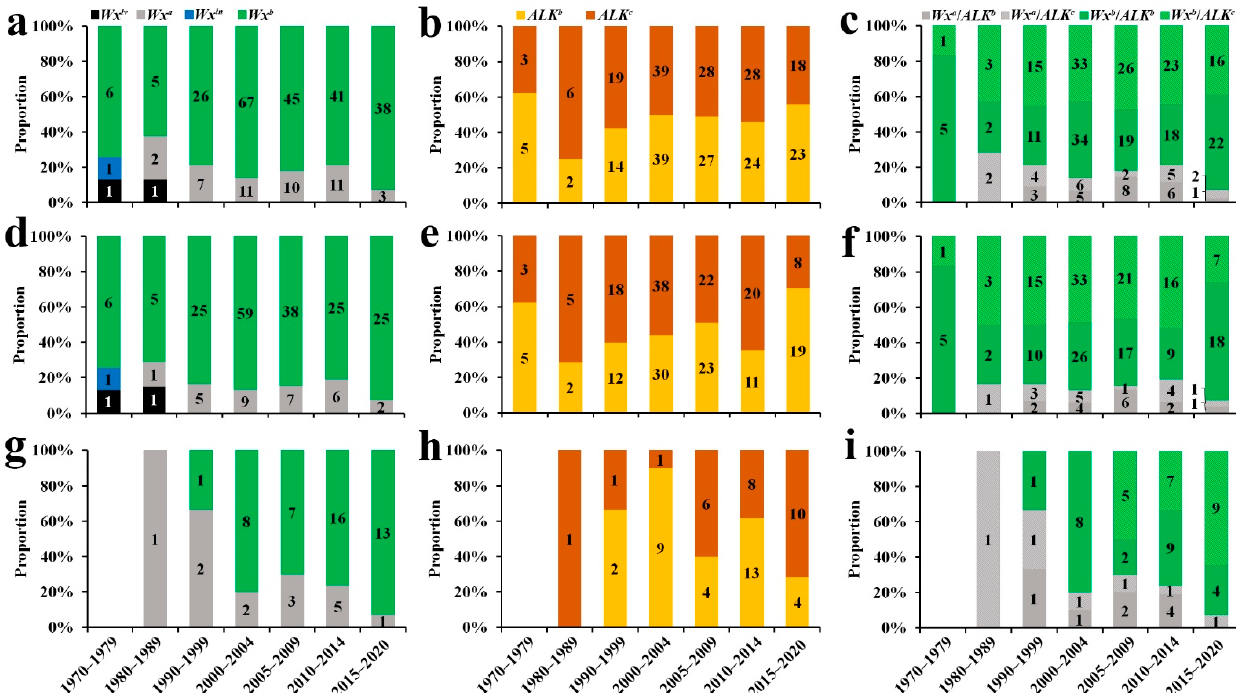
Figure 3. Frequency distribution of different rice materials based on different alleles. ( a , d , g ) Fre- quency distribution of different alleles of Wx . ( b , e , h ) Frequency distribution of different alleles of ALK . ( a